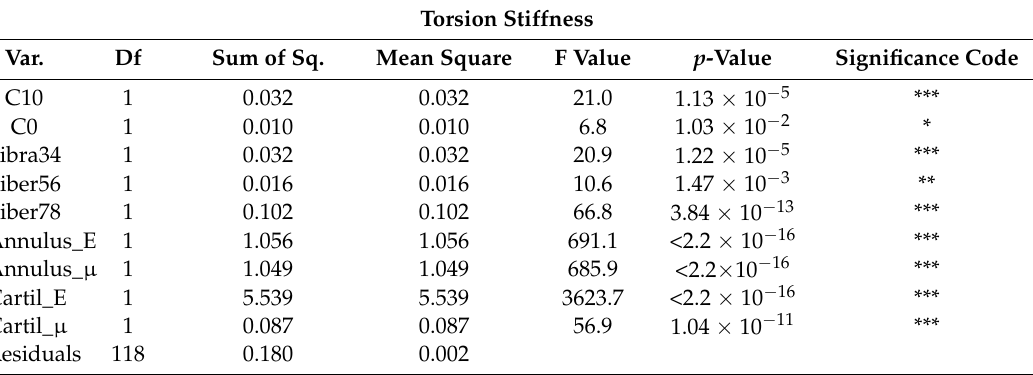
Table 25. ANOVA table for a torsion stiffness linear